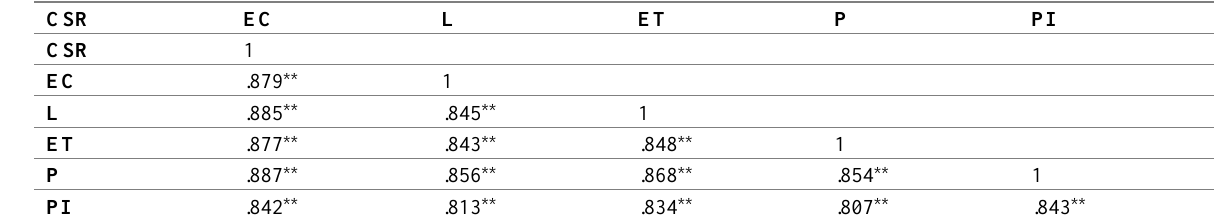
Table 11: Pearson Correlations for Independent Variable and Dependent Variable18